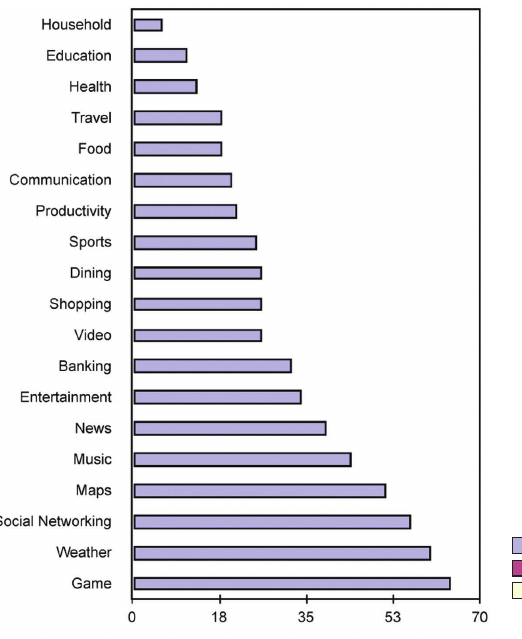
Figure 1 Category of apps used in 30 days of Q2 2011